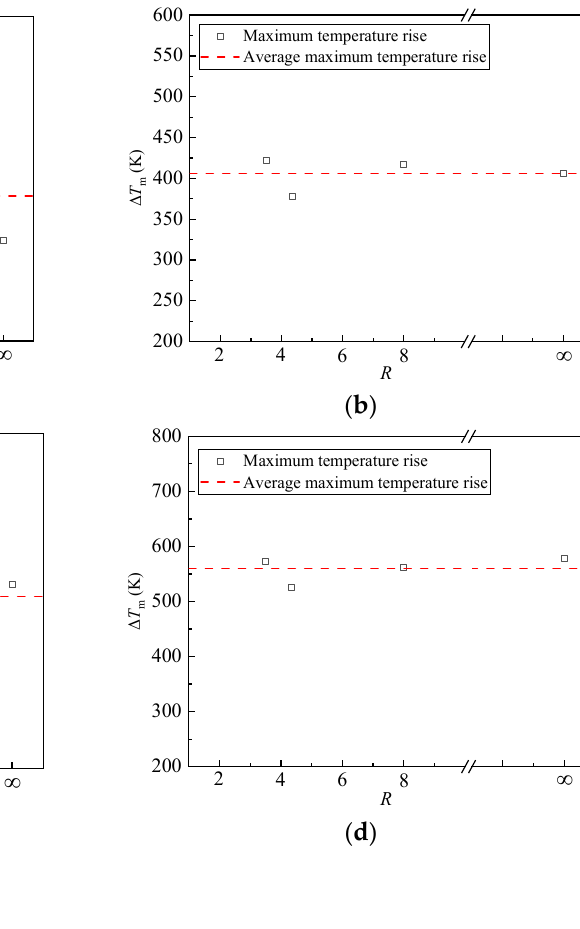
Figure 3. Instantaneous flame image with different HRRs: ( a ) Q Q  = 1.62 kW; ( d ) Q  = 2.43 kW; ( e ) Q  = 4.06 kW.